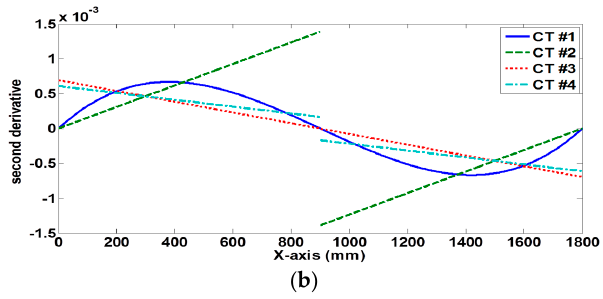
Figure 7. First ( a ) and second ( b ) derivatives of contraction wall equations.